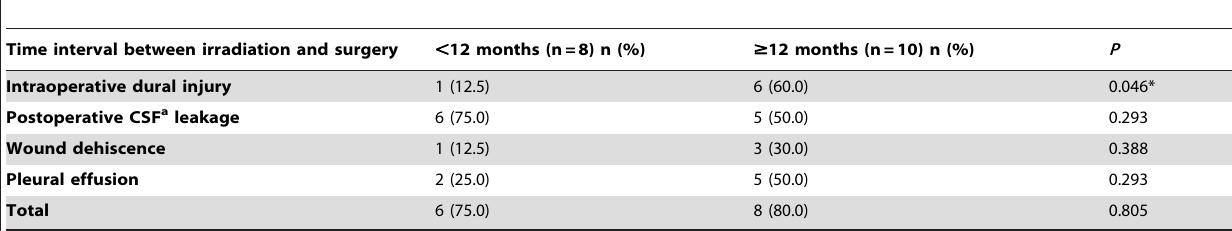
Table 5. Complication rates associated with the time interval between the end of irradiation and surgery.